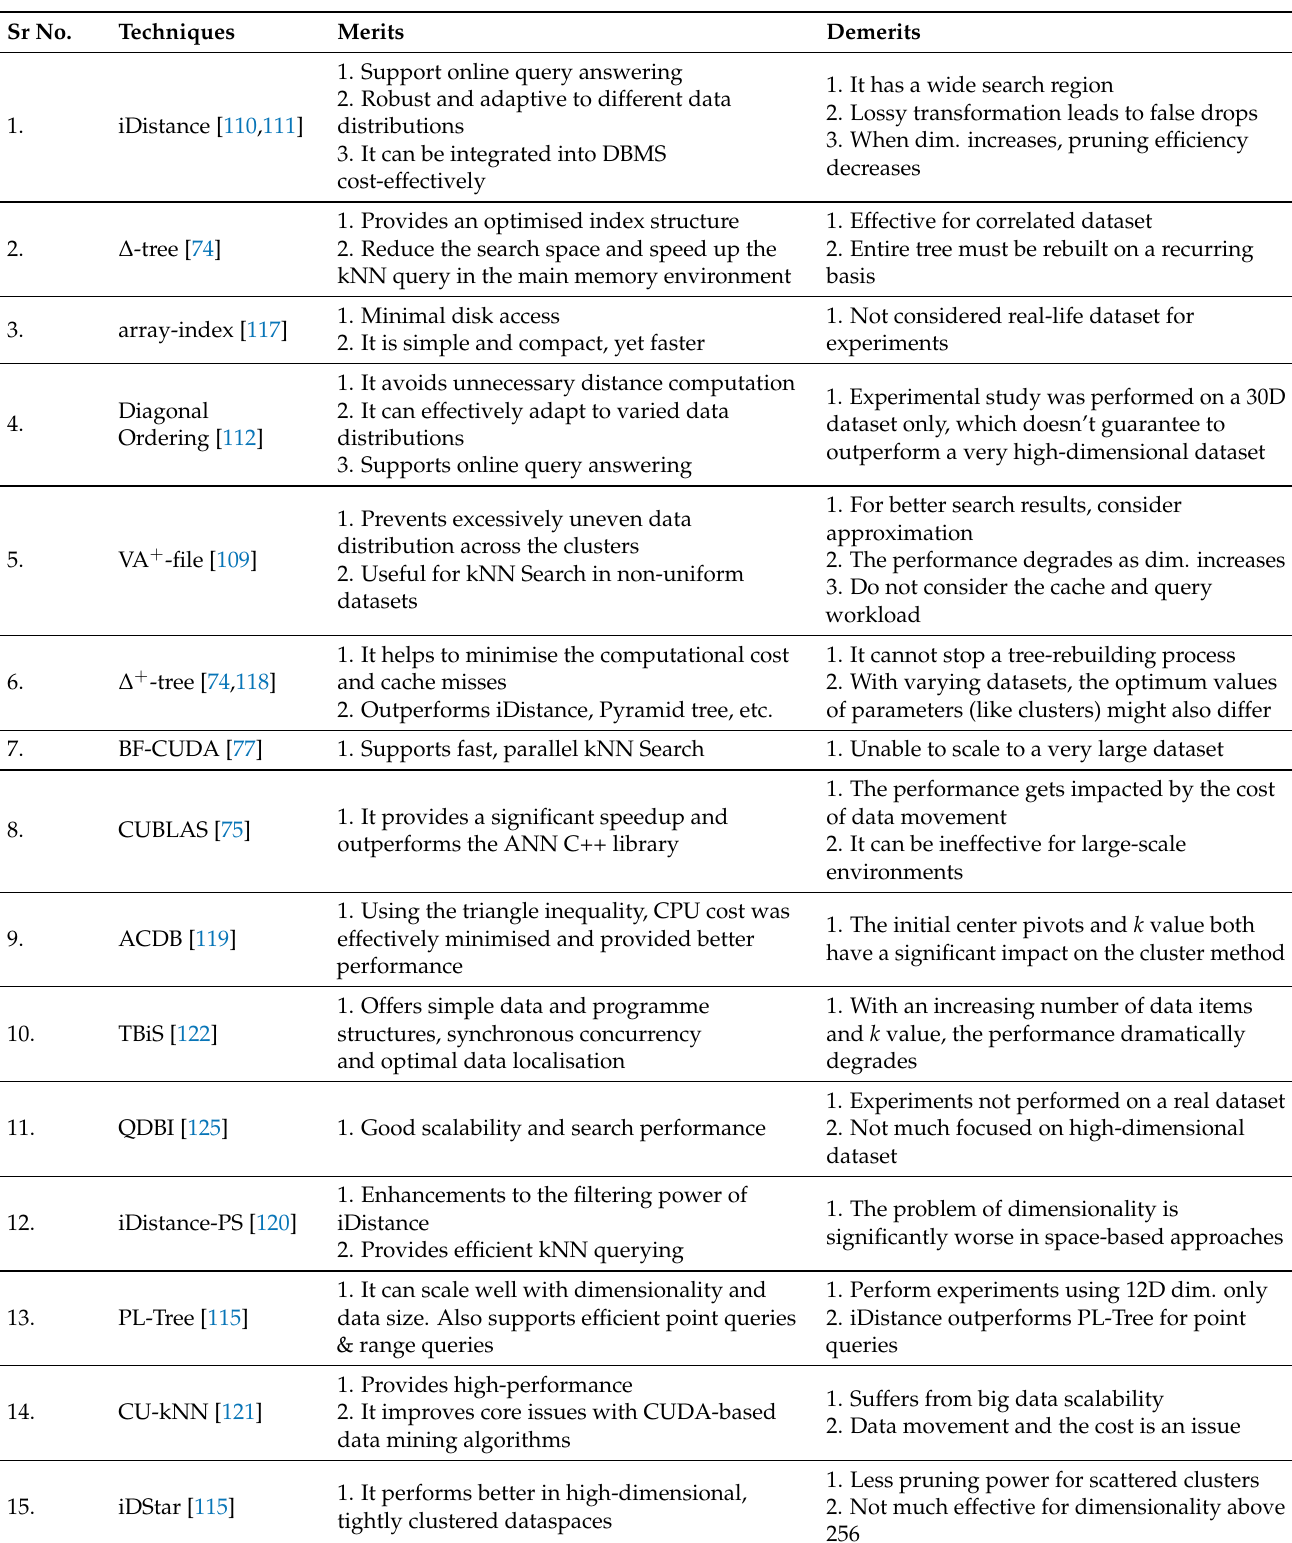
Table 5. Comparative Study of kNN